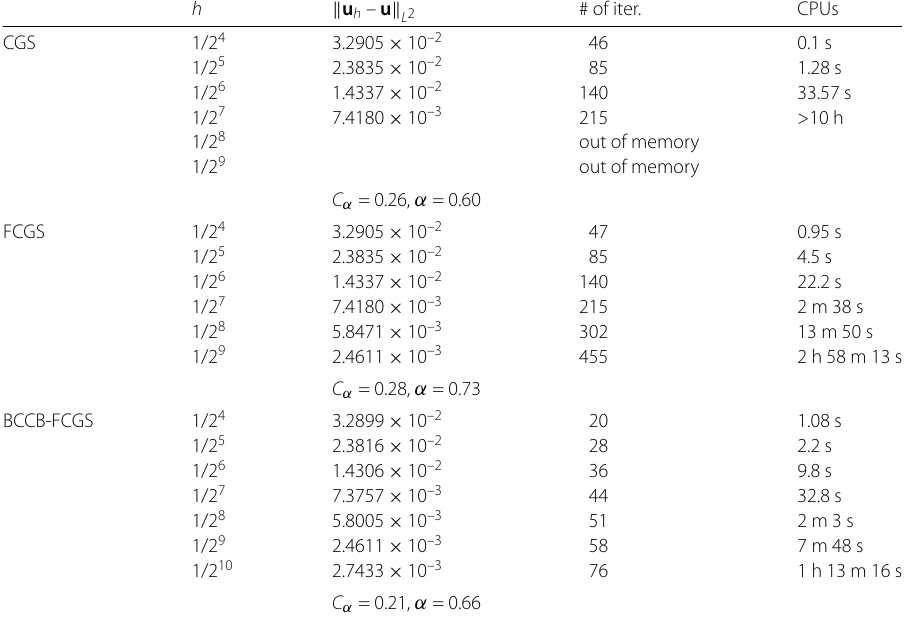
Table 1 Performance of CGS, FCGS, and BCCB-FCGS in Example 1